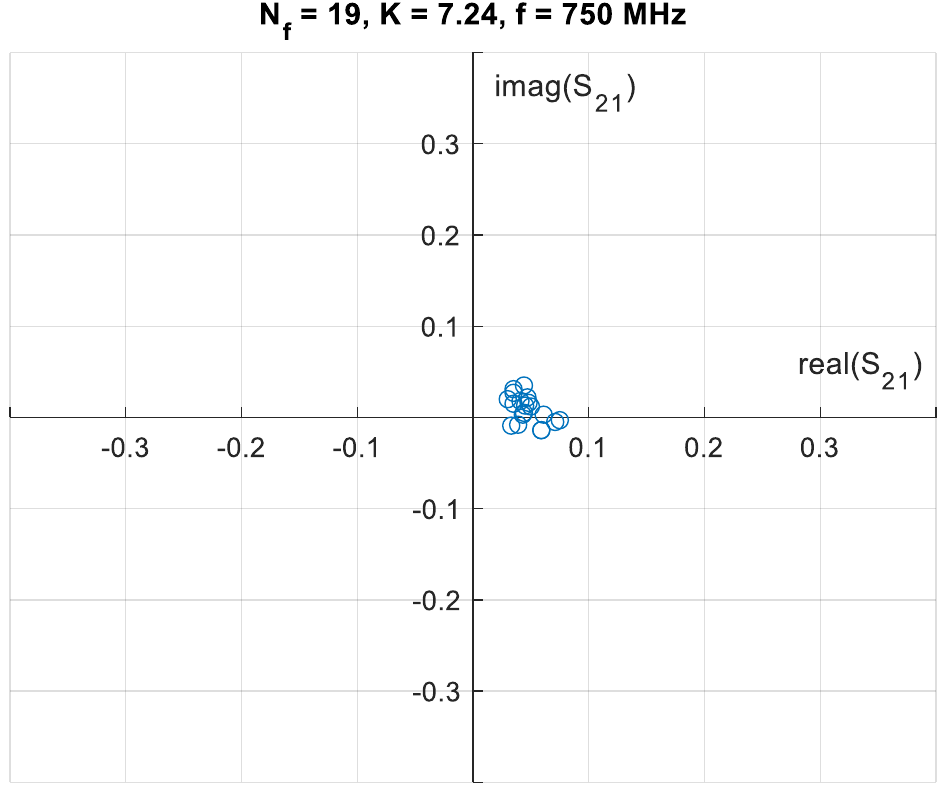
Figure 5. Scatter plot of S 21 relative at the subset of 19 electromagnetic field realizations simulated at 750 MHz. The corresponding value of the Rician K-factor is 7.24.